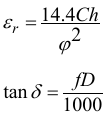
Fig. 1 The diffraction pattern of pre-synthesised sample A